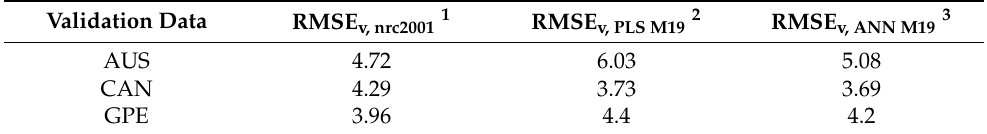
Table 5. Comparison of out-of-sample country-independent performance between models M19, M19b and NRC, 2001